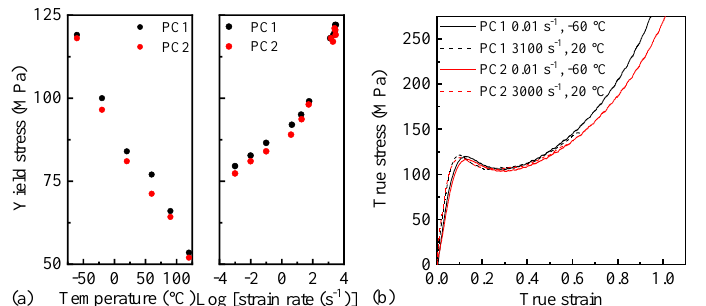
Fig. 4. (a) Yield stress versus temperature and yield stress versus log strain rate of PC1 and PC2 (b) Comparing large strain behaviour between low temperature quasi-static and high rate room temperature tests on PC1 and